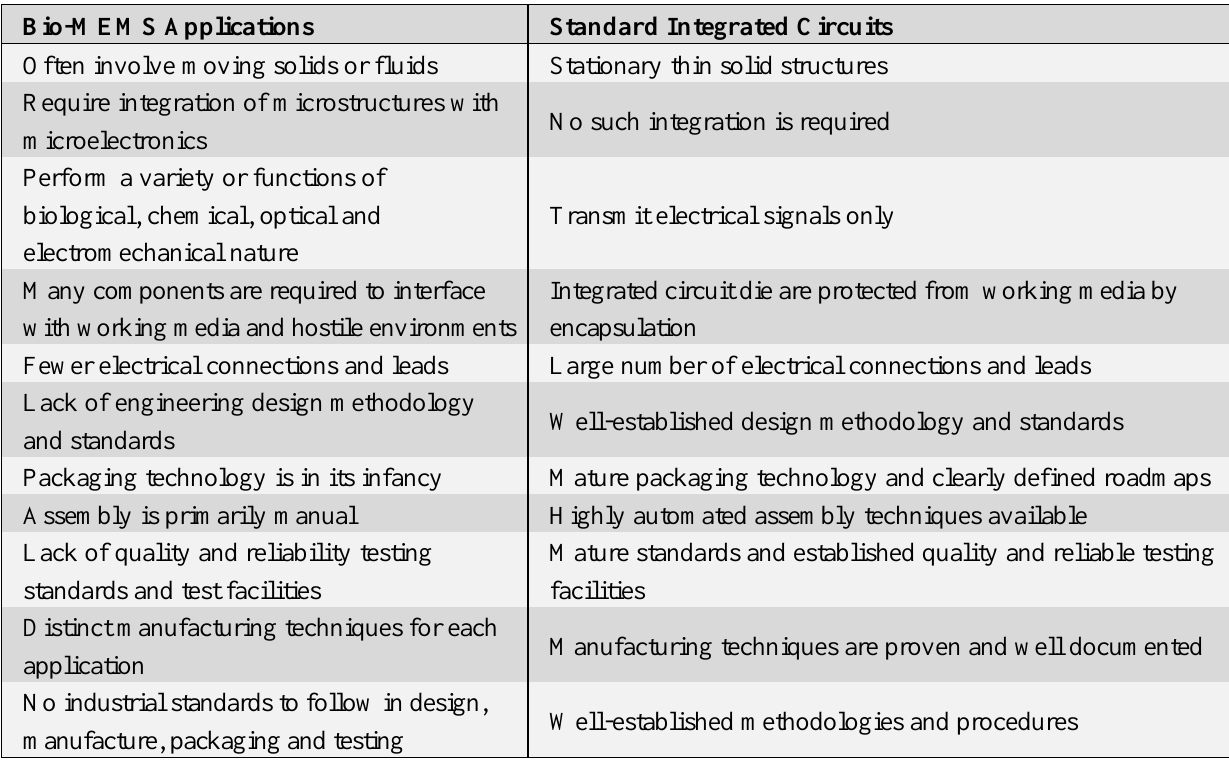
Table 2. Summary of MEMS packaging requirements versus standard integrated circuit packaging (adapted from [113]).